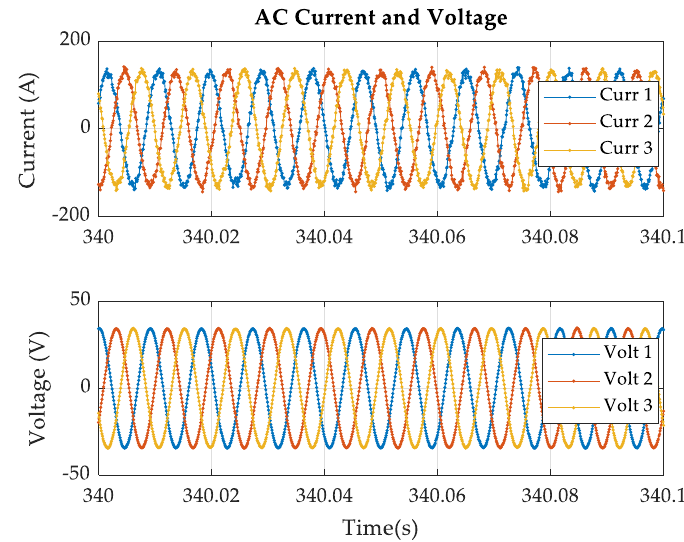
Figure 27. Three-phase inverter current and voltage.